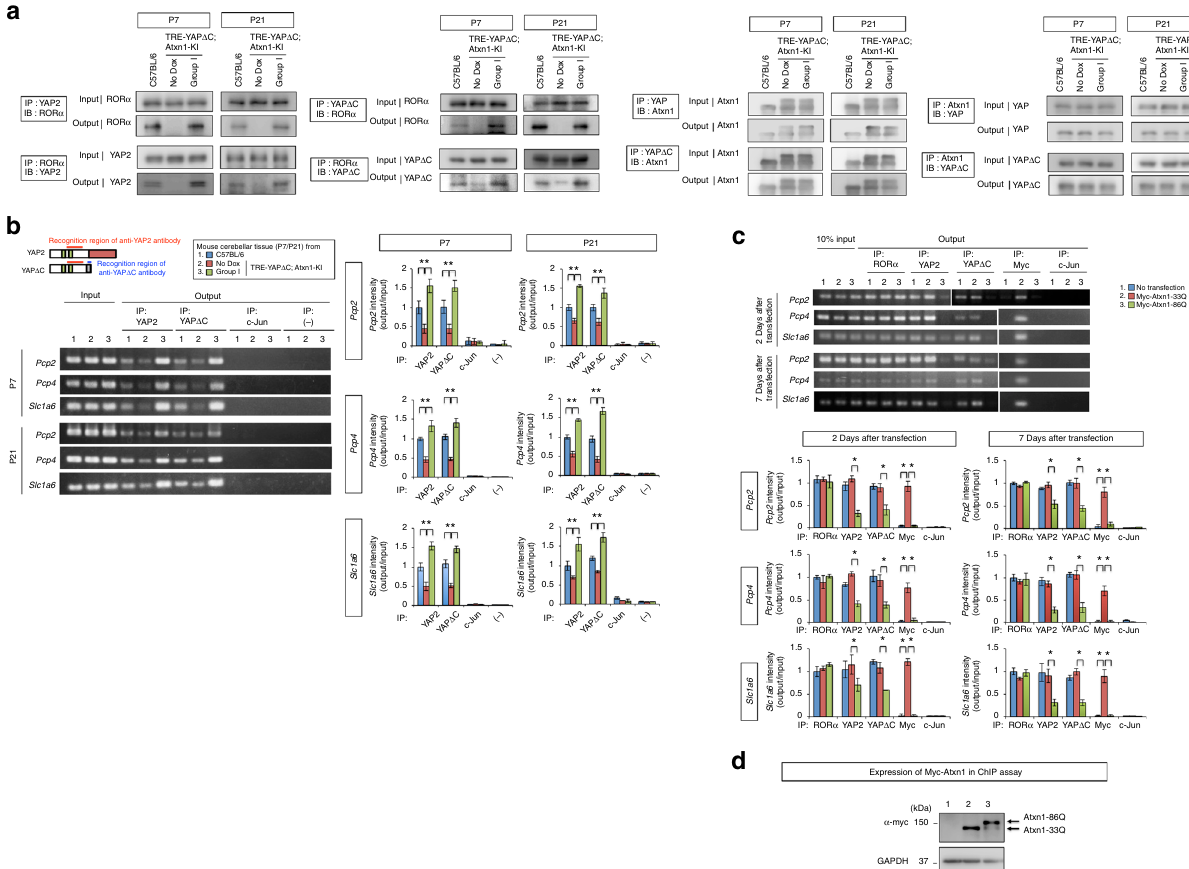
Fig. 6 Mutant Atxn1 impairs the interaction of YAP/YAPdeltaC with ROR α in vivo. a Immunoprecipitation analyses of mouse cerebellar cortex at P7 and P21 revealing reduced interaction between ROR α with YAP/YAPdeltaC in Atxn1-KI mice (No-Dox) and the recovery of the interaction in Group I mice. b ChIP assay was performed on mouse cerebellar cortex using anti-YAP2 antibody (recognizing both full-length YAP and YAPdeltaC) or anti-YAPdeltaC antibody (recognizing only YAPdeltaC). The ROR α -responsive elements in the upstream region of Pcp2 , Pcp4 , and Slc1a6 were ampli fi ed using speci fi c primers. Quantitative analyses of band intensities are shown in the graphs at right. Double asterisks indicate statistical signi fi cance ( p < 0.01, N = 4) in one-way ANOVA with post hoc Tukey ’ s HSD test. c ChIP assay was performed on primary cerebellar neurons 2 or 7 days after transfection. Expression of Myc-Atxn1-86Q decreased the amount of YAP or YAPdeltaC in the ROR α transcription complex on the cis -elements of Pcp2 , Pcp4 , and Slc1a6 , whereas mutant Atxn1 did not change the amount of ROR α attached to the cis -element. Immunoprecipitation of c-Jun was performed as a negative control. Double asterisks indicate statistical signi fi cance ( p < 0.01, N = 5) in one-way ANOVA with post hoc Tukey ’ s HSD test. d Protein levels of Myc-Atxn1-33Q and Myc-Atxn1-86Q, determined by western blot using anti-Myc antibody, in the samples shown in Fig.